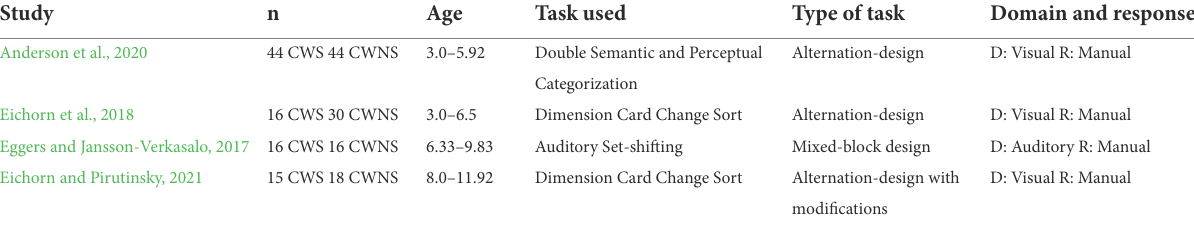
TABLE 2 Summary of behavioral studies assessing cognitive flexibility in CWS and